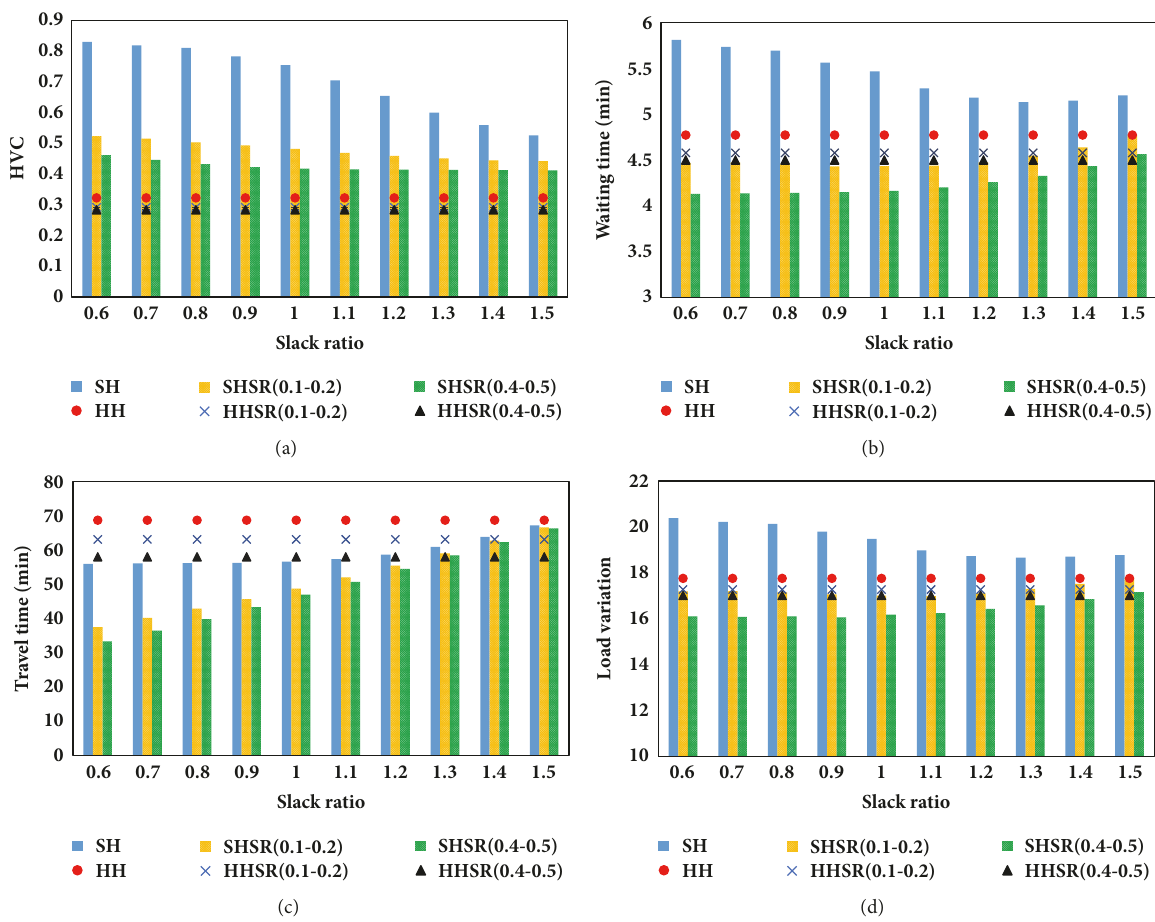
Figure 3: Performance measures under different control policies: (a) HVC; (b) 𝐸(𝑤) ; (c) average travel time; (d) load